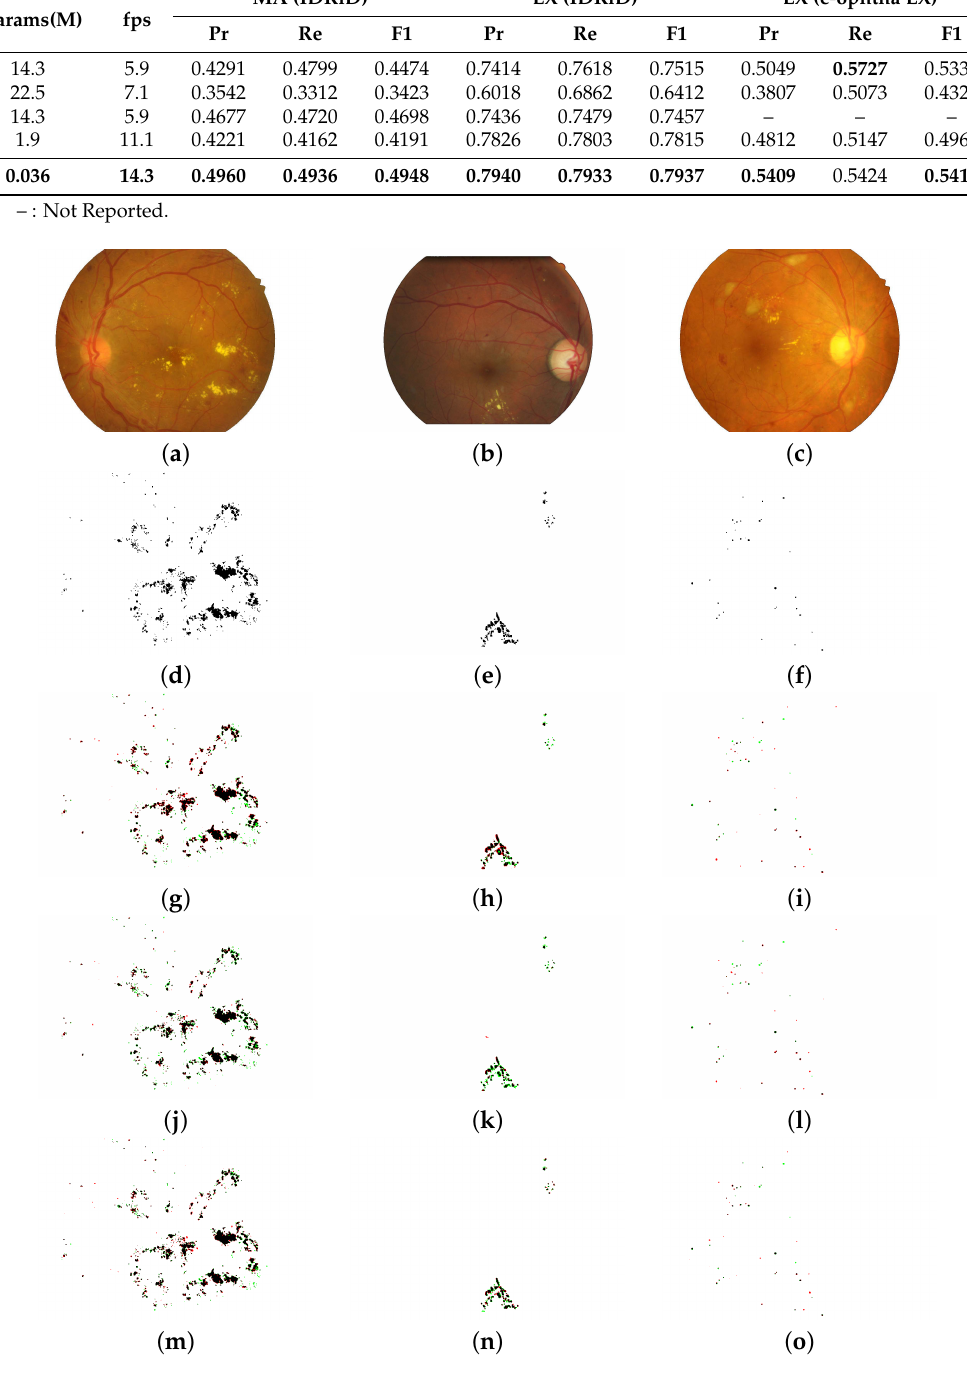
Figure 4. Lesion segmentation binary maps of the LightEyes and other methods (TPs are marked as black, FPs are marked as red, and FNs are marked as green). The first and the second column denote EX segmentation on the IDRiD dataset, and the third row denotes MA segmentation on the